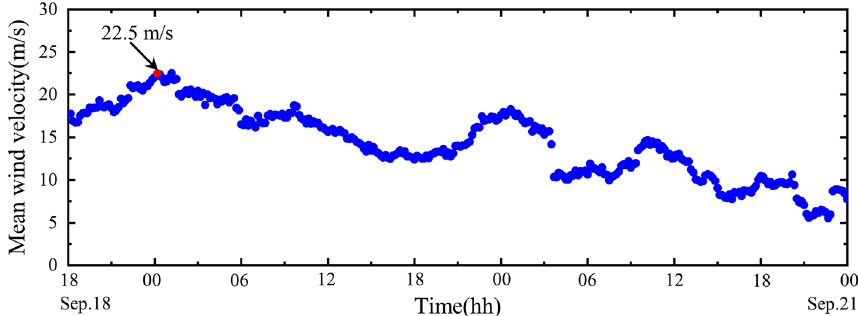
Fig. 2 Measured 10-min mean wind velocities during PSRB observation